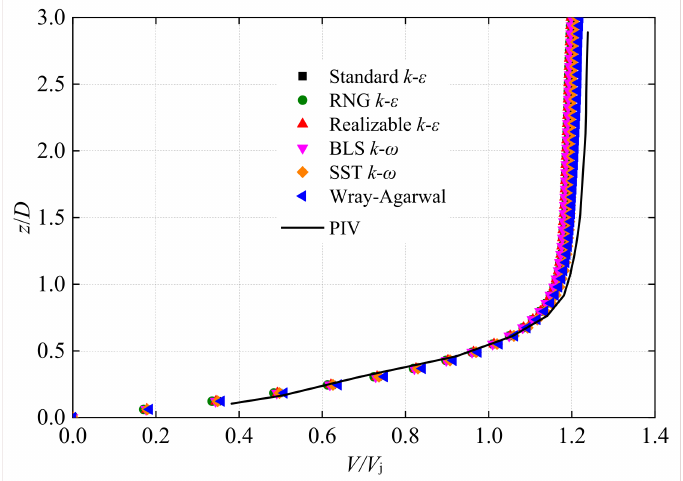
Figure 4. The axial distribution of the dimensionless velocity V/V j at the center of the jet.